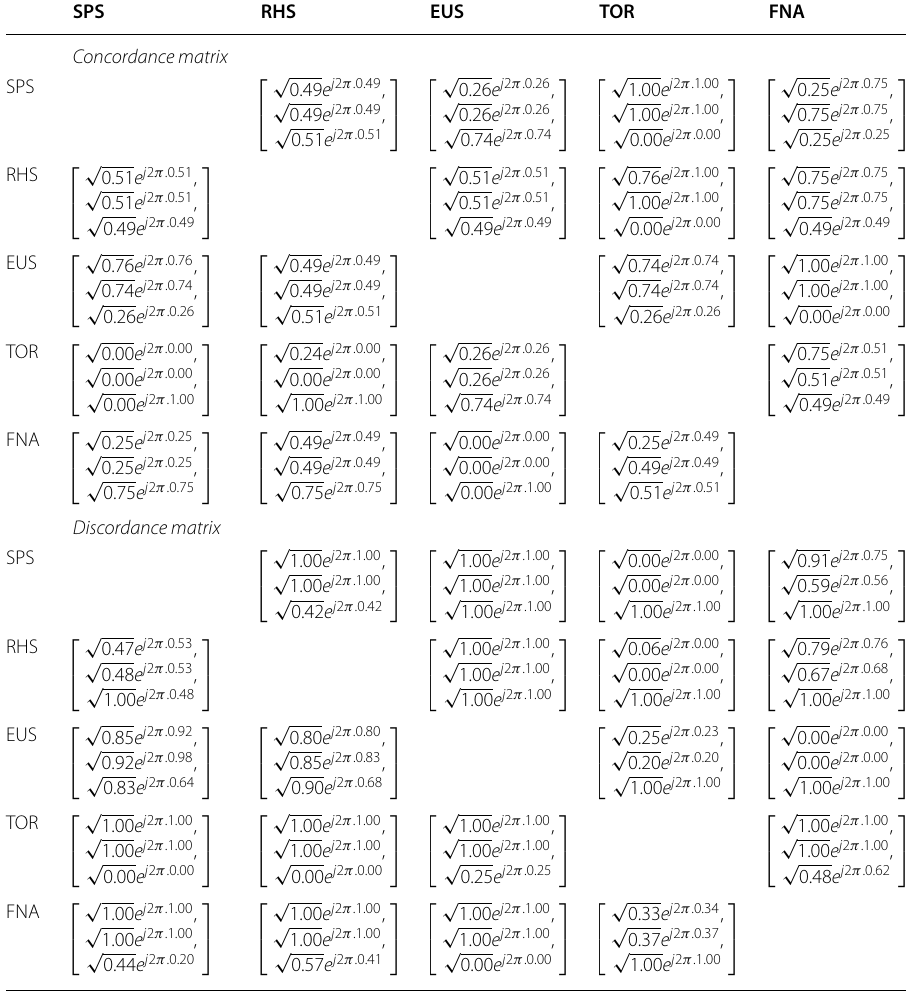
Table 15 Concordance and discordance interval matrixes for the quantum spherical fuzzy sets SPS RHS EUS TOR FNA Concordance matrix